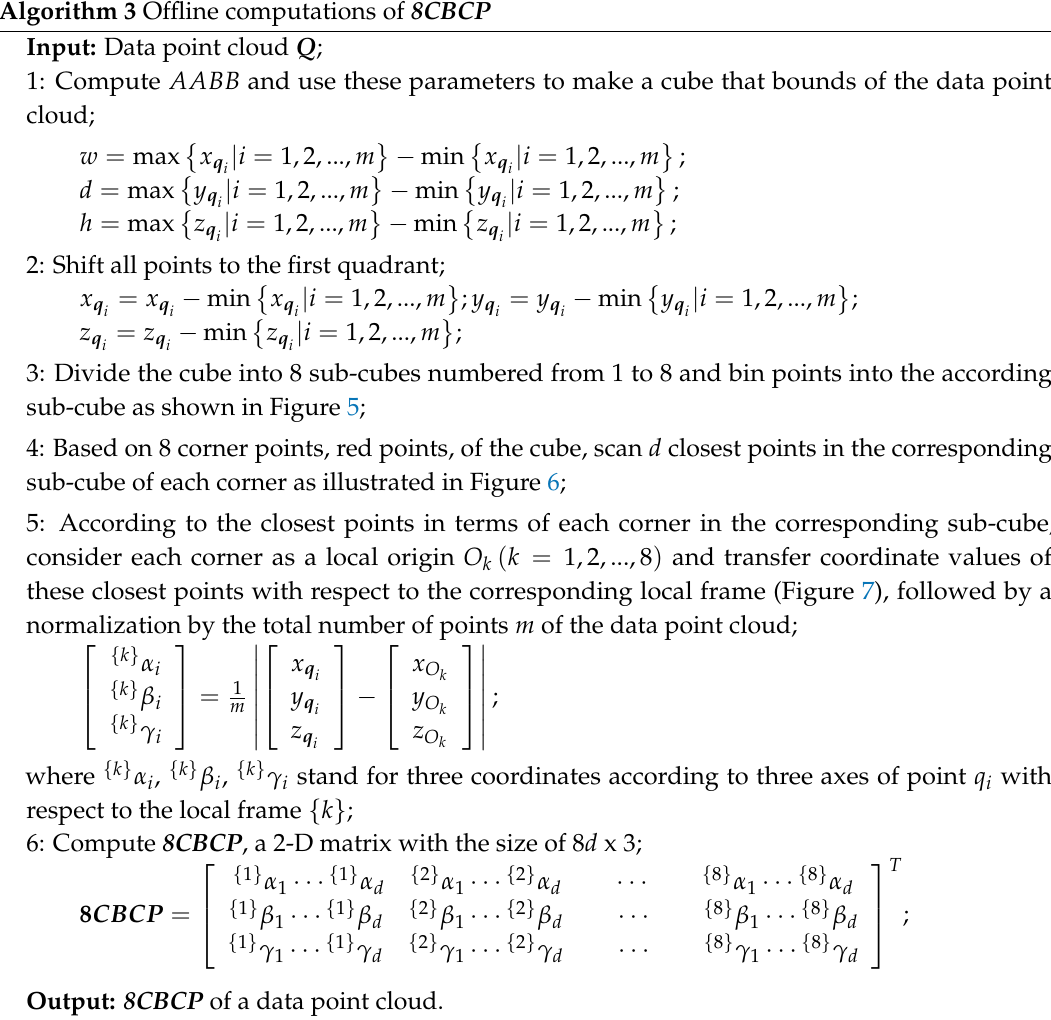
Algorithm 3 Offline computations of